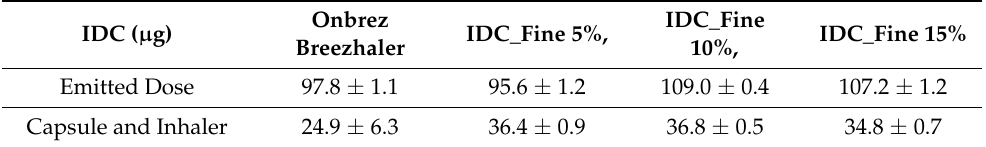
Table 1. Indacaterol (IDC) µ g remained inside the capsule and inhaler after aerosolization of the reference product Onbrez and tested formulations containing different amount of fine lactose ( n = 3, mean ±